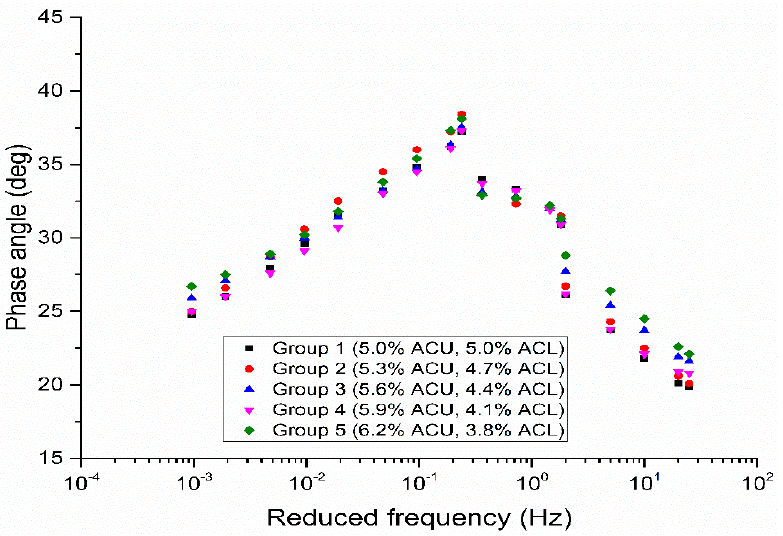
Figure 8. The master curves of phase angle of five groups of samples (reference temperature: 20 °C).